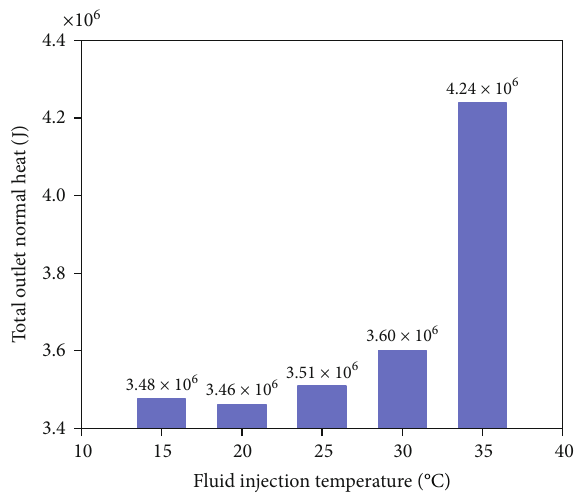
Figure 11: Comparison of total outlet normal heat at di ff erent fl uid injection temperatures.